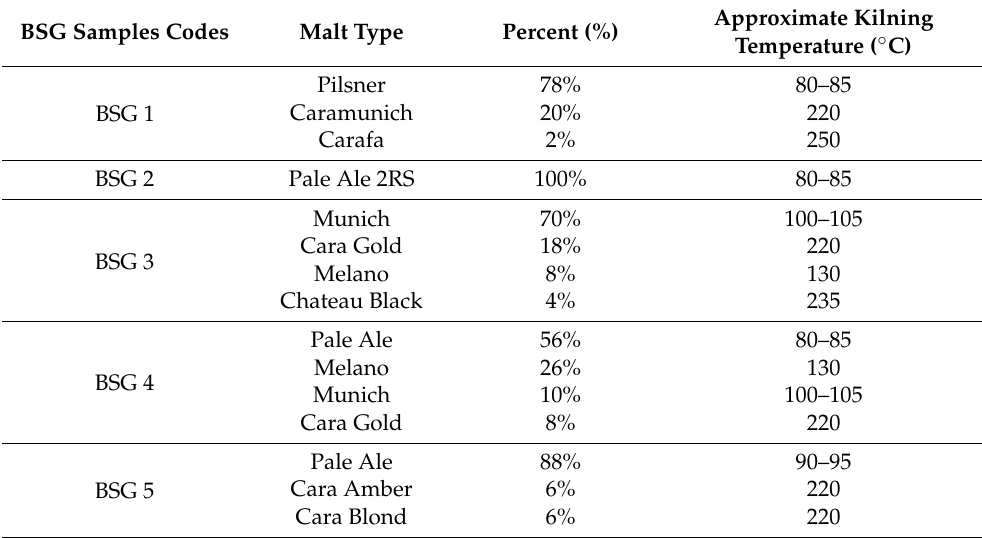
Table 10. BSG (brewers spent grains) samples codification, type of malt used and kilning